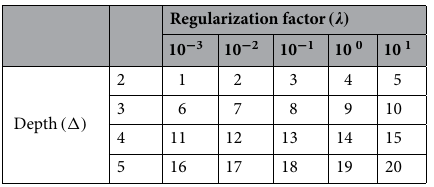
Table 2. The bijective relationship between (� , (cid:31) ) and (cid:31) .